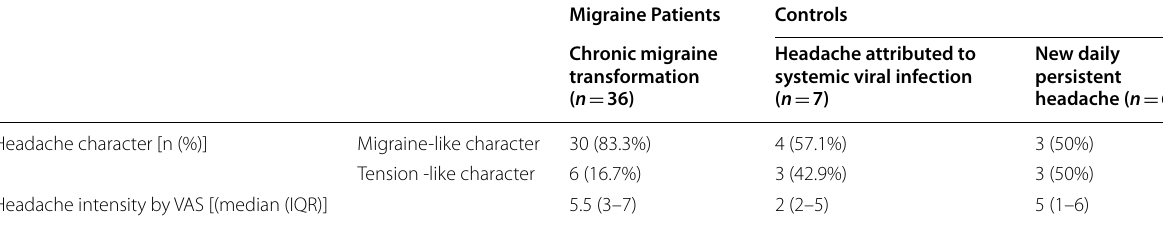
VAS Visual analogue scale